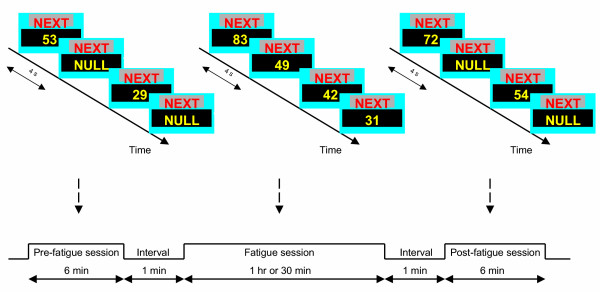
Experimental procedure. Experiment included 3 sessions: Pre-fatigue, fatigue, and post-fatigue sessions. Subjects performed pre-fatigue, fatigue, and post-fatigue sessions lying on the MRI scanner table with both ears plugged. The time interval between 2 successive sessions was 1 min. For the fatigue session (fatigue-inducing period), normal subjects performed visual search trials (present or absent trials) for 1 hour, while CFS patients performed visual search trials for 30 min. During this period, continual visual search trials were performed; null trials were not included. In the pre- or post-fatigue sessions, subjects performed visual search or null trials for 6 min.